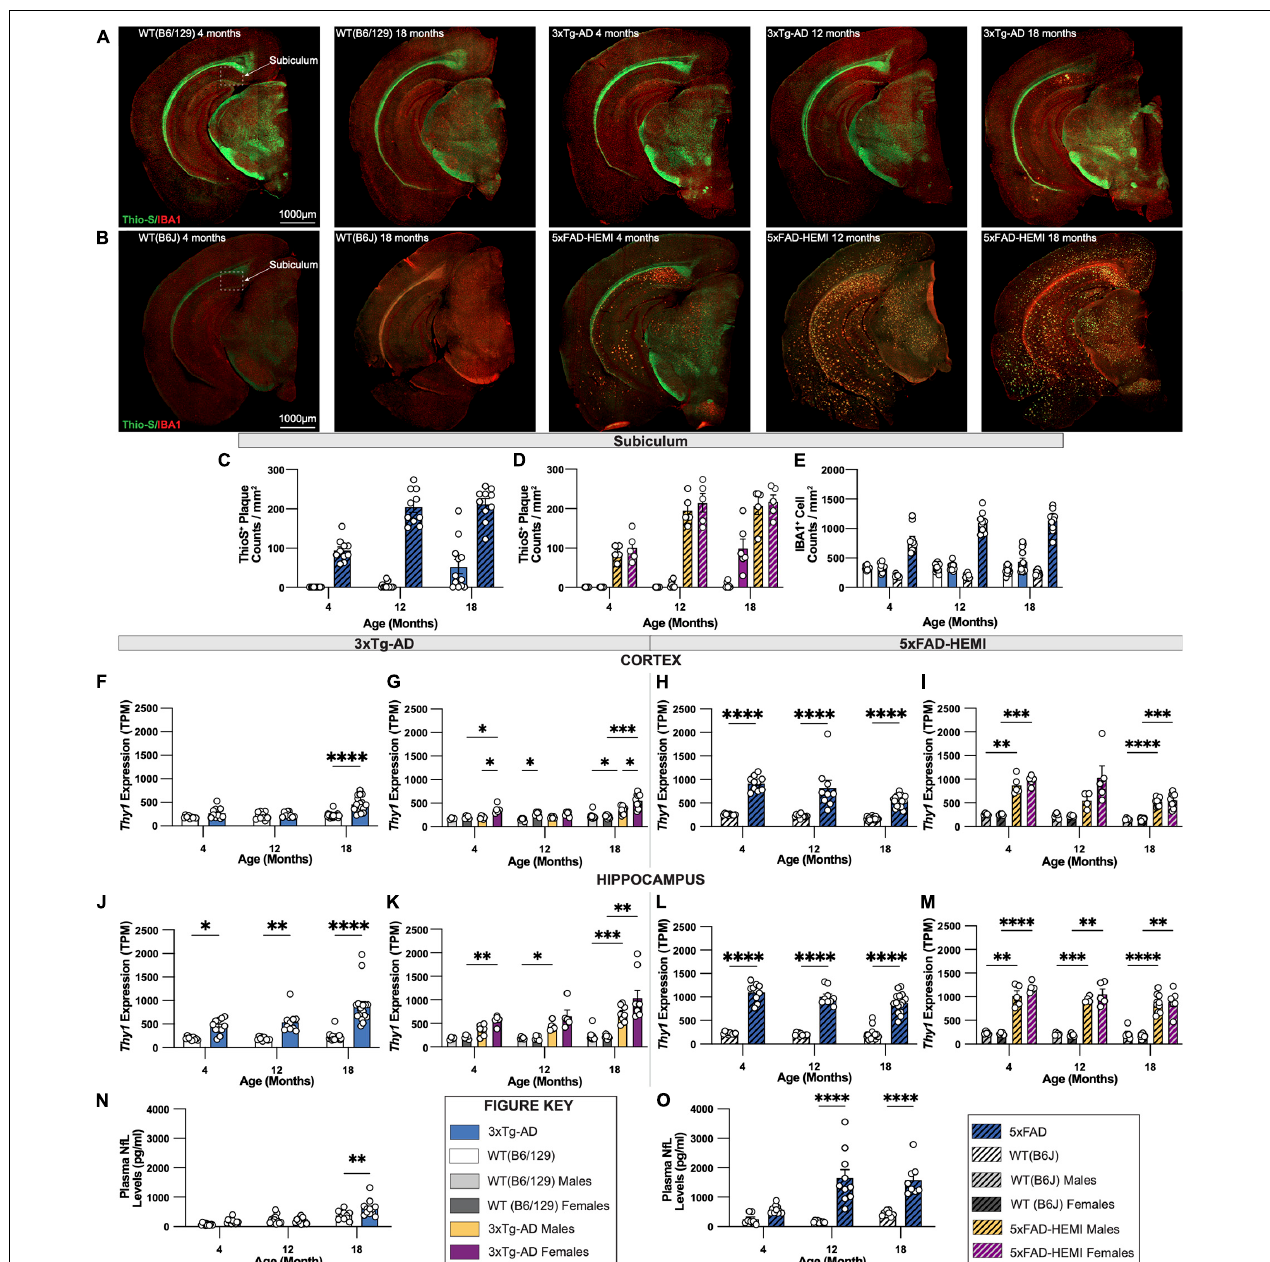
FIGURE 9 | Comparison of fibrillar amyloid plaque accumulation in 3xTg-AD and 5xFAD mice. (A) Representative images of brain hemispheres of WT(B6;129) at 4- and 18-month and 3xTg-AD mice at 4-, 12-, 18-month stained with Thio-S/IBA1. (B) Representative stitched brain hemispheres of WT(B6J) at 4- and 18-month and hemizygous 5xFAD mice at 4-, 12-, 18-month stained with Thio-S/IBA1. (C,D) Quantification for density of Thio-S + plaques in subiculum hippocampal regions in 3xTg-AD and 5xFAD mice showed differences in plaque burden between mouse models and sexes. (E) Quantification for IBA1 immunostaining for microglia in subiculum hippocampal regions reveals age-related differences between mouse models. (F,G) TPM values for Thy1 expression in micro-dissected cortical lysates revealed an age-associated increase in 3xTg-AD, as well as sex-differences driven by female mice. (H,I) TPM values for Thy1 expression in micro-dissected cortical lysates in 5xFAD mice displays a significant increase compared to B6J wildtype mice, yet no sex differences were observed. (J,K) TPM values for Thy1 expression in micro-dissected hippocampal lysates demonstrate higher Thy1 expression in 4-, 12-, and 18-month-old 3xTg-AD mice. (L,M) TPM values for Thy1 expression in micro-dissected hippocampal lysates display a similar increase in Thy1 expression compared to B6J wildtype controls with no sex differences within groups. (N,O) Quantification of neurofilament-light chain (NfL) levels of plasma from 3xTg-AD and 5xFAD using Mesoscale Singleplex technology demonstrated an age-related increase in 3xTg-AD mice at only the 18-month timepoint (N) , while age-related increases were found in 5xFAD mice at both 12-month and 18-month timepoints (O) . n = 5–10 mice per genotype/age/sex. Data are represented as mean ± SEM. ∗ p ≤ 0.05, ∗∗ p ≤ 0.01, ∗∗∗ p ≤ 0.001, ∗∗∗∗ p ≤ 0.0001.